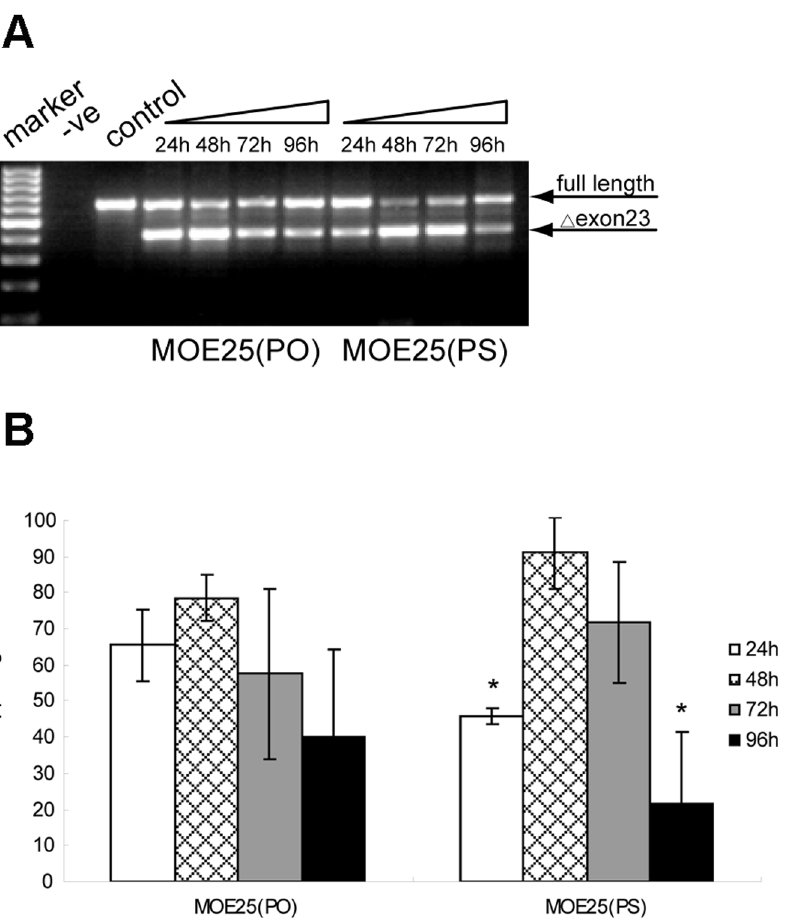
Figure 2. Time-course analysis for different MOE AOs in H 2 K mdx cells. (A) RT-PCR results for MOE25(PS) and MOE25(PO) AOs in H 2 K mdx cells at different time-points from 24 to 96 h after transfection. (B) Quantification of percentage of exon 23 skipping for MOE25(PS) and MOE25(PO) AOs at different time-points. The data indicate that MOE25(PS) induced significantly higher percentage of exon 23 skipping at 48 h than those of other time-points, with the exception of 72 h time-point (*p , 0.05).